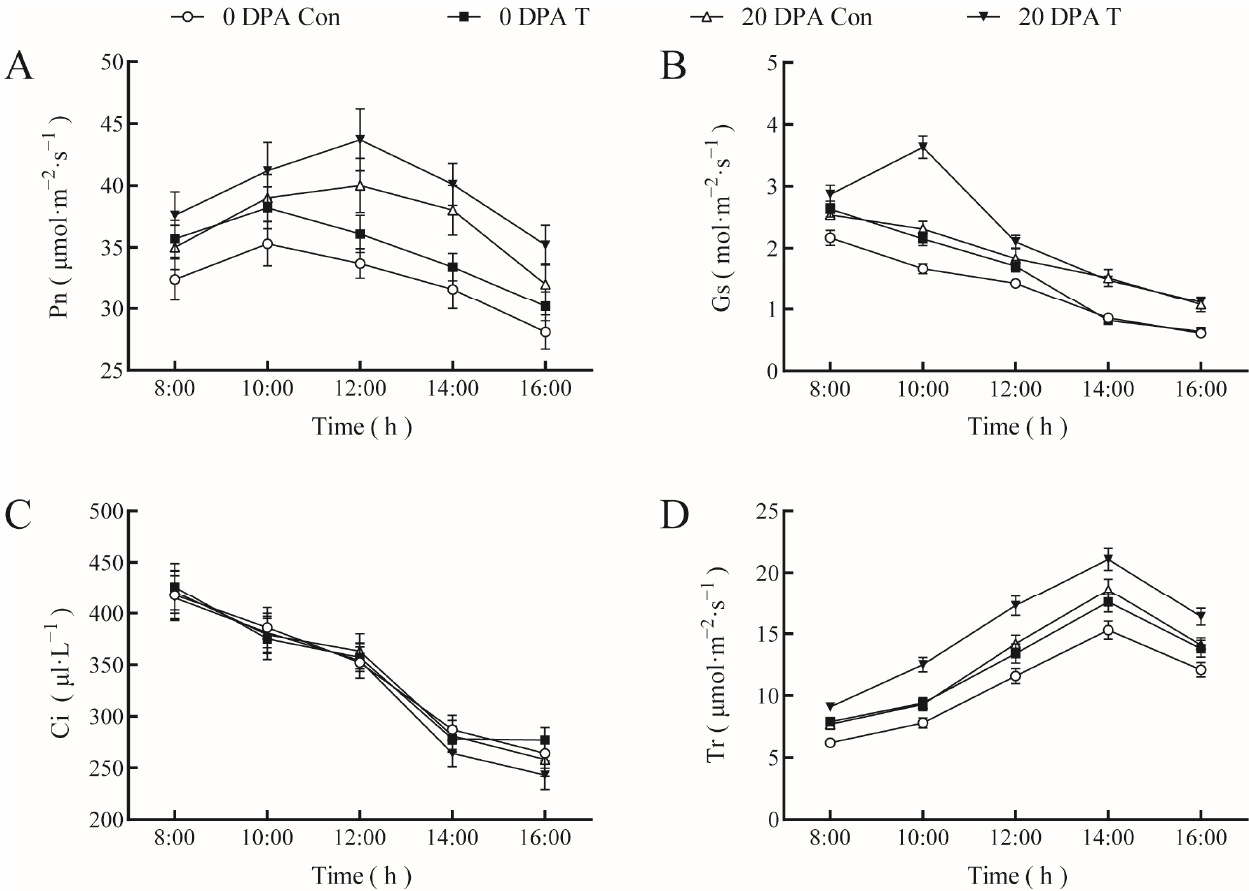
Figure 3. Effects of NAA and EBR on the photosynthetic characteristics of giant pumpkin leaves. ( A ), Pn, ( B ), Gs, ( C ), Ci, ( D ), Tr. Con: control; T: giant pumpkin leaves and fruits sprayed with 20 mg · L − 1 NAA + 1.0 mg · L − 1 EBR at 20 d after planting, 0 DPA, 10 DPA, and 20 DPA. The “Con” and “T”